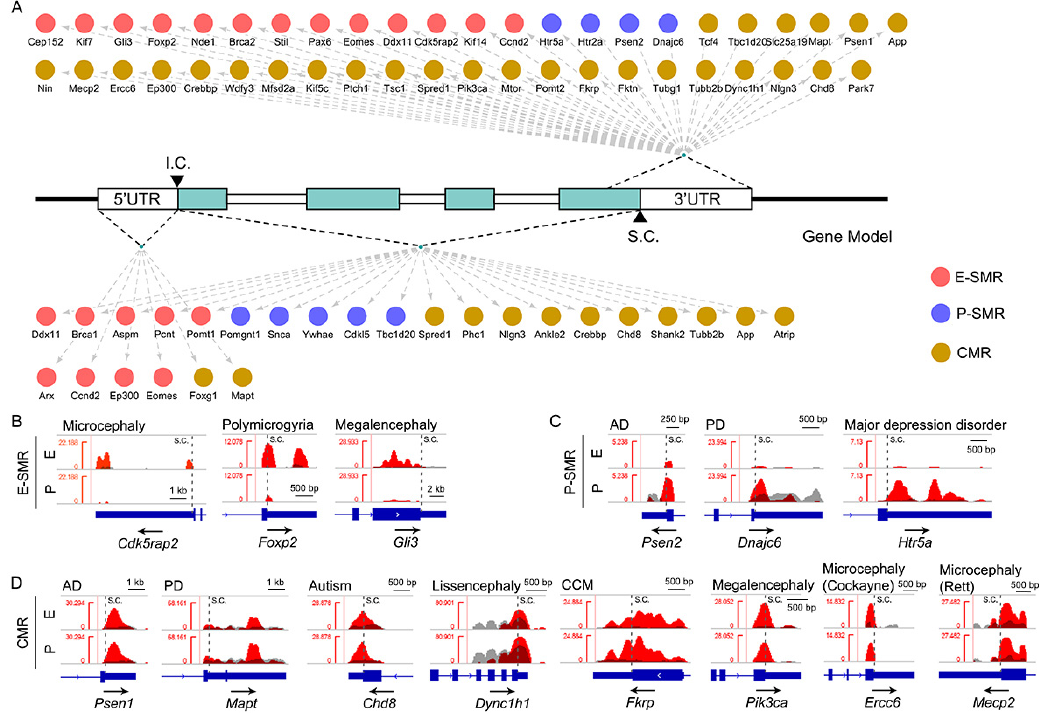
Figure 7. Status of m 6 A-methylation sites of genes in neurological disorders. ( A ) Identification of methylated genes and their specifically methylated patterns in RNA transcripts. The red dots stand for E-SMRs, the blue dots stand for P-SMRs, and the dark yellow dots stand for CMRs. ( B ) IGV analysis of three representative E-SMRs that act as pathogenetic genes (Cdk5rap2, Foxp2 and Gli3) associated with neurological disorders. ( C ) IGV analysis of three representative P-SMRs (Psen2, Dnajc6 and Htr5a). ( D ) IGV analysis of eight representative CMRs (Psen1, Mapt, Chd8, Dync1h1, Fkrp, Pik3ca, Ercc6 and Mecp2) encoding neurological disease-risk